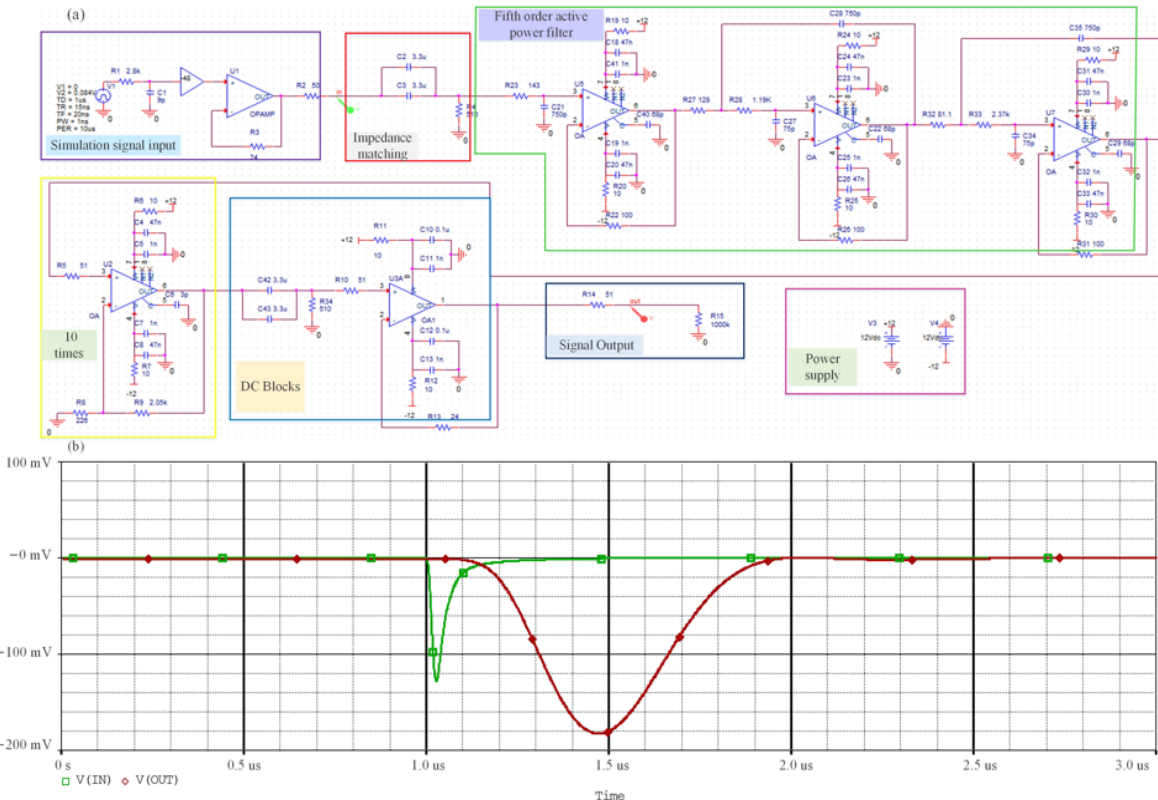
Figure 11. ( a ) The simulation of the optimized ACB at magnification of 10. ( b ) The green line is the input signal and the red line is the output signal.